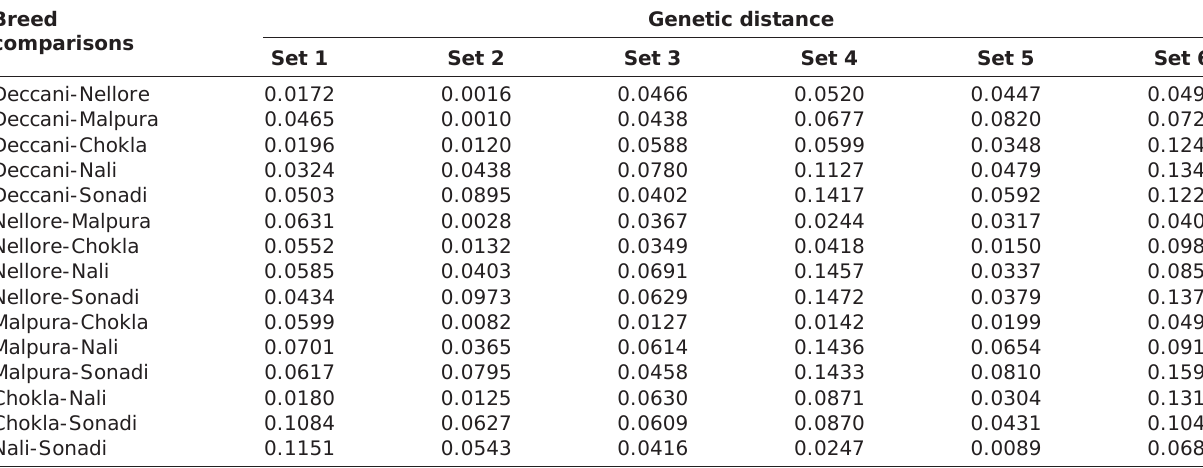
Table 1: Estimated genetic distance in all sets among six sheep breeds. Breed comparisons